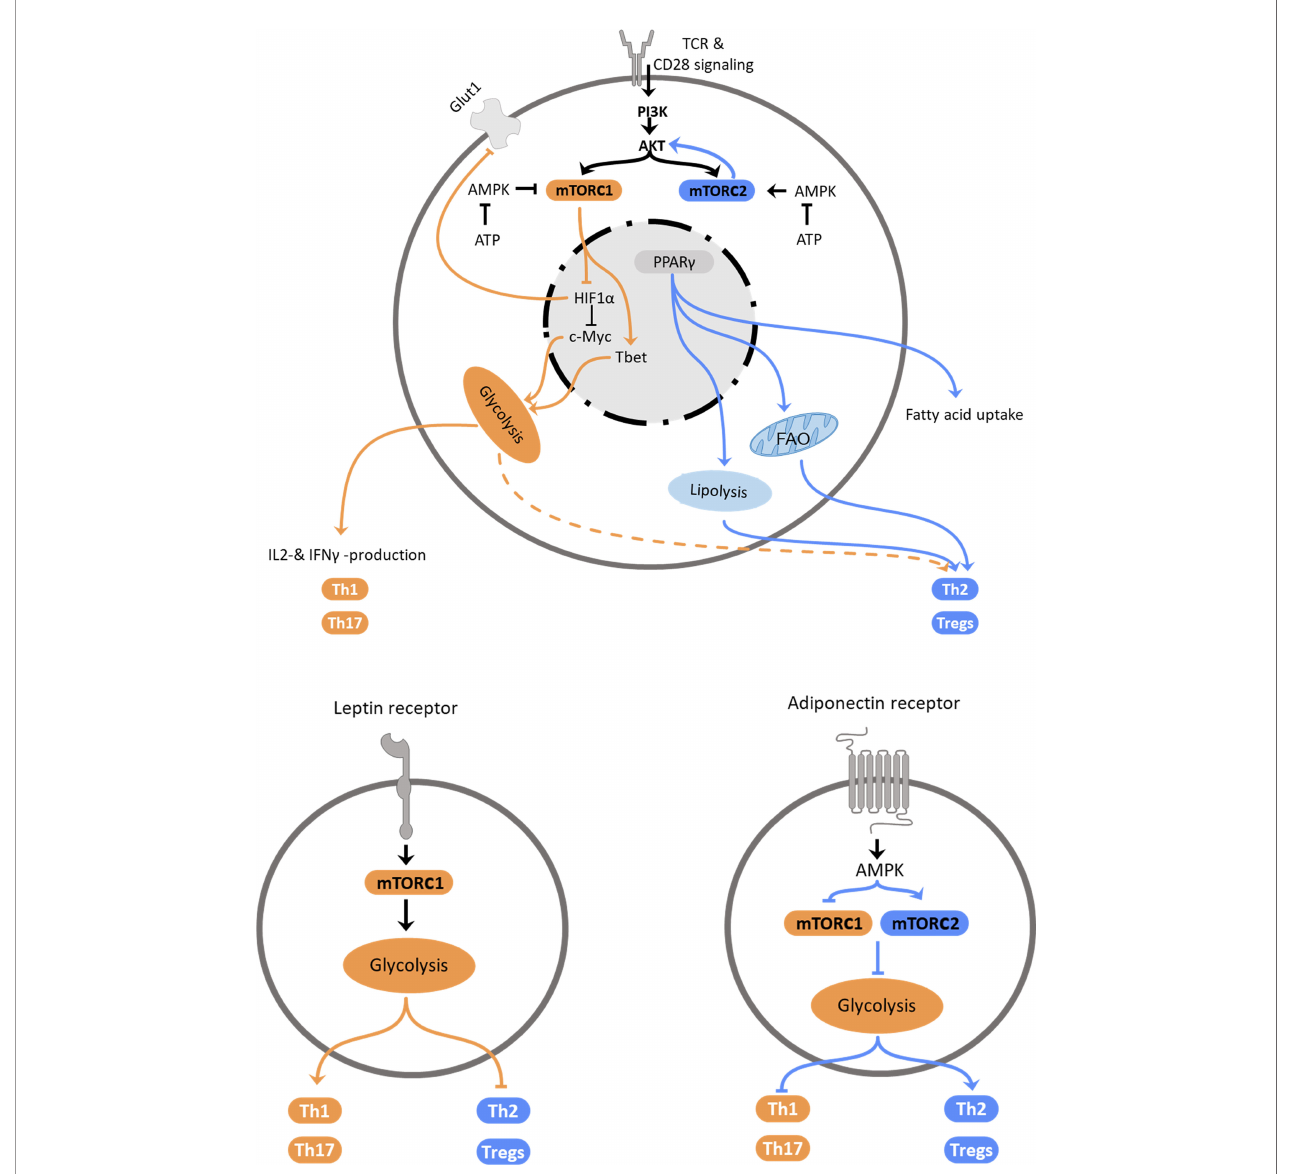
FIGURE 1 | Regulation of Th2 metabolism. Top: Schematic representation of intracellular mechanisms affecting T helper cell polarization. Central elements in fl uencing cellular polarization include mTORC1 and mTORC2, which are regulated by PI3K/Akt and AMPK, PPAR g and HIF-1 a . These pathways regulate utilization of glycolysis, which promotes pro-in fl ammatory subset differentiation, or fatty acid oxidation and lipolysis that promote anti-in fl ammatory Th2 and Treg differentiation. Bottom: Schematic representation how the adipokines leptin (left) and adiponectin (right) promote T helper cell subset polarization via regulation of metabolic